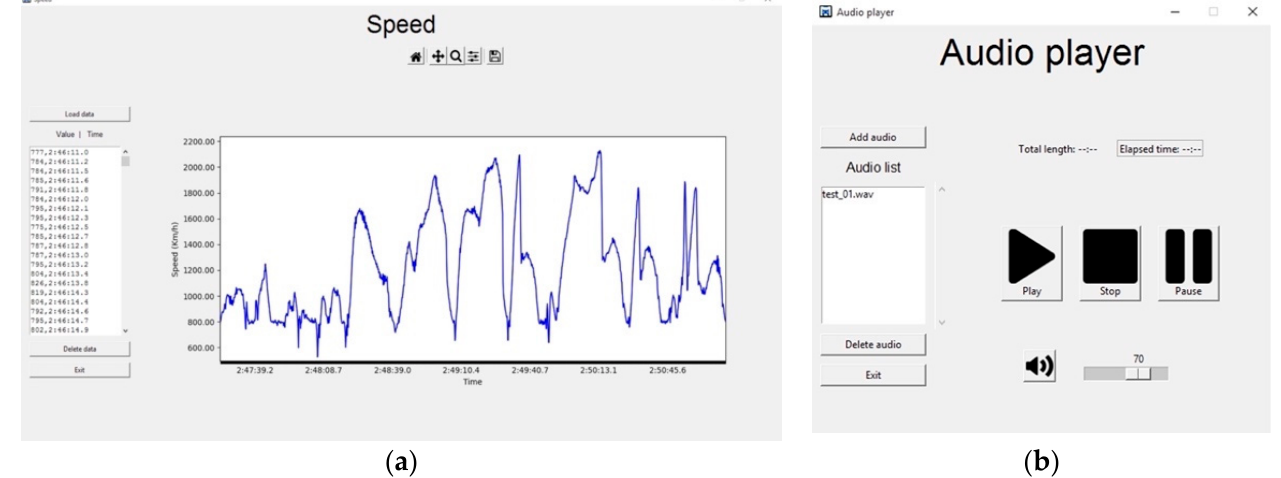
Figure 10. Data in the GUI: ( a ) is the vehicle’s velocity during the journey and ( b ) is the screenshot of the audio player.